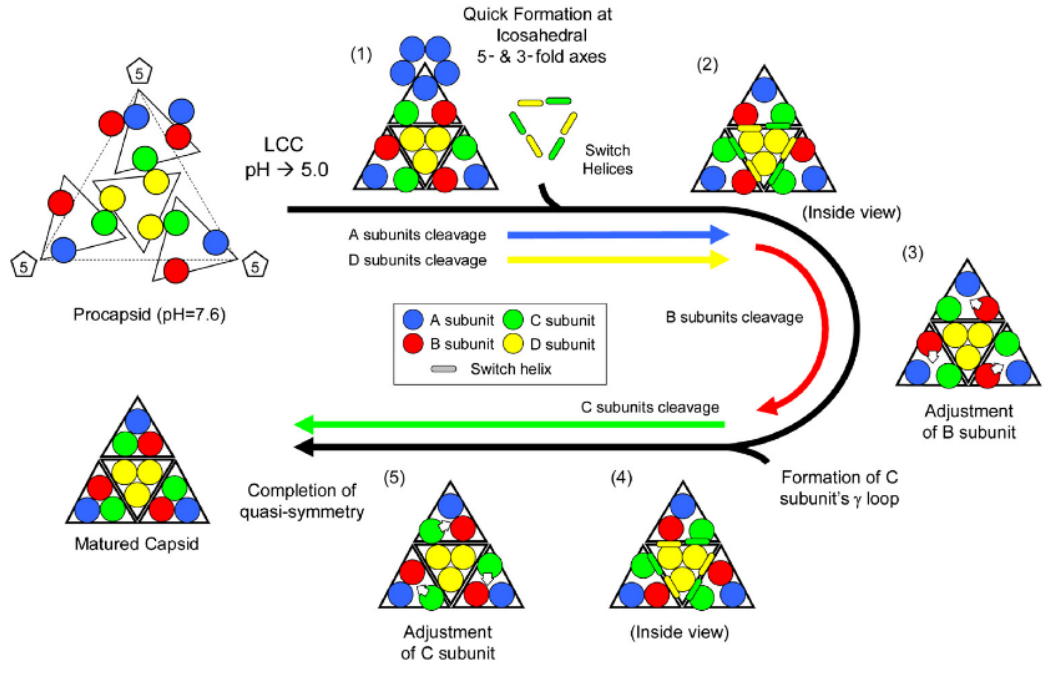
Figure 8. Proposed mechanism of subunit rearrangement during autoproteolysis. Initial LCC prompts quick cleavage in A/D. C/D switch helix interaction causes subtle changes that prompt B to cleave. B cleavage allows rearrangement in quaternary structure that promotes C to cleave, rearrange, yielding a mature faceted capsid with bent and flat contacts. Reproduced with permission from Matsui et al .